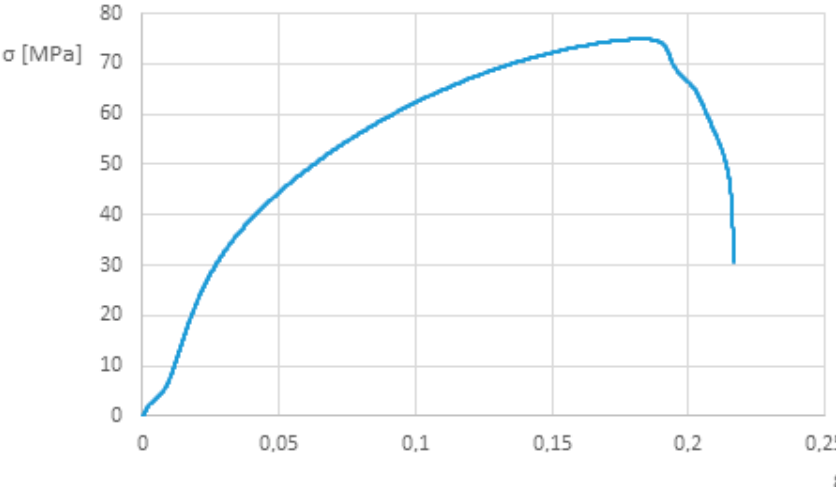
Figure 4. Tensile stress-strain curve of Ertalon 6 SA white.